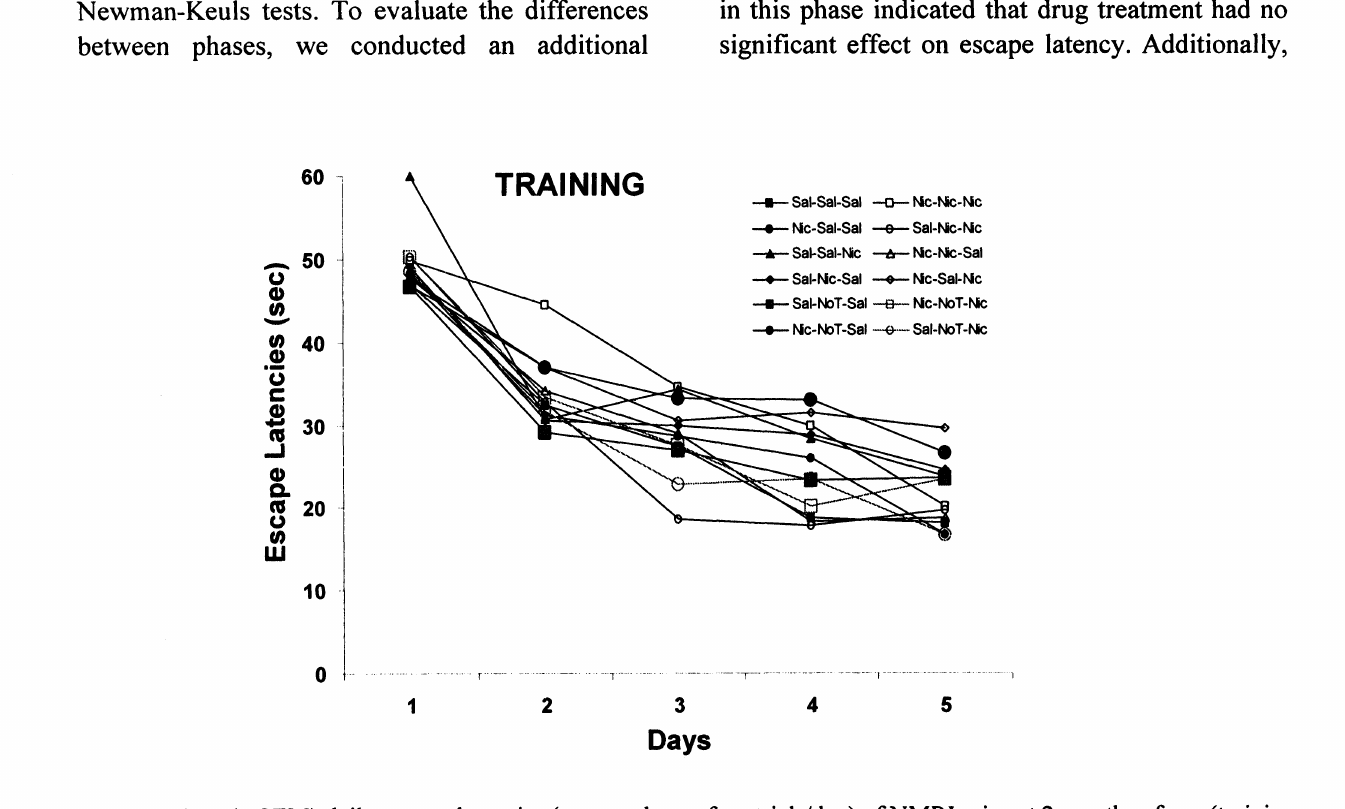
Fig. 1: Mean (+ SEM) daily escape latencies (averaged over four trials/day) of NMRI mice at 2 months of age (training phase). In this phase, mice assigned to 12 experimental groups were evaluated. Each group is named according to the drug treatment in each phase of the longitudinal study: nicotine ic), physiological saline (Sal) and no .drug treatment or behavioral manipulation (Not). In this training phase, 6 groups received saline and 6 groups received nicotine, as indicated with the first abbreviation used for the legend of each